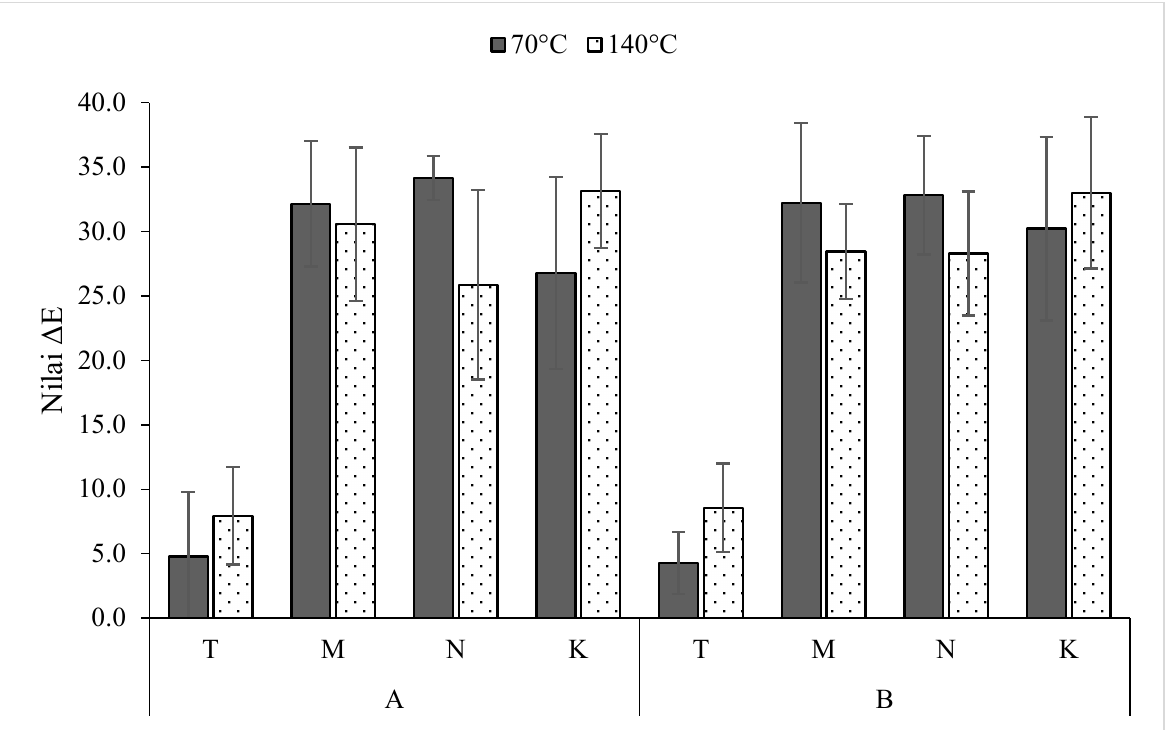
Figure 3. Color change ( ∆ E ) in treated manii wood with heating at 70 or 140 ◦ C and with boric acid (B), without boric acid (A), with neem oil (M), with tamanu oil (N), with candlenut oil (K), and without oil (T). Table 7. The Duncan test for color change ( ∆ E Table 6. Compilation of analyses of variance (ANOVA).